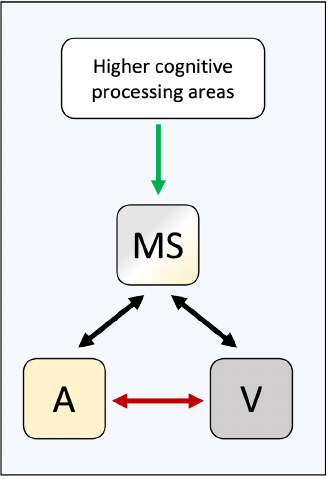
Figure 3. Possible neural substrates of binding tendency. The learned or hardwired association between the senses may be mediated by the lateral connectivity between unisensory regions, here denoted by the red arrow between auditory and visual regions. The strength of this connection would map to the degree of binding tendency. Extant models of multisensory integration have utilized this mechanism (see [45] as an example). Top-down influences on binding tendency may be mediated by projections from cognitive processing regions in the frontal lobe to multisensory processing areas involved in causal inference. This is denoted by the green arrow.